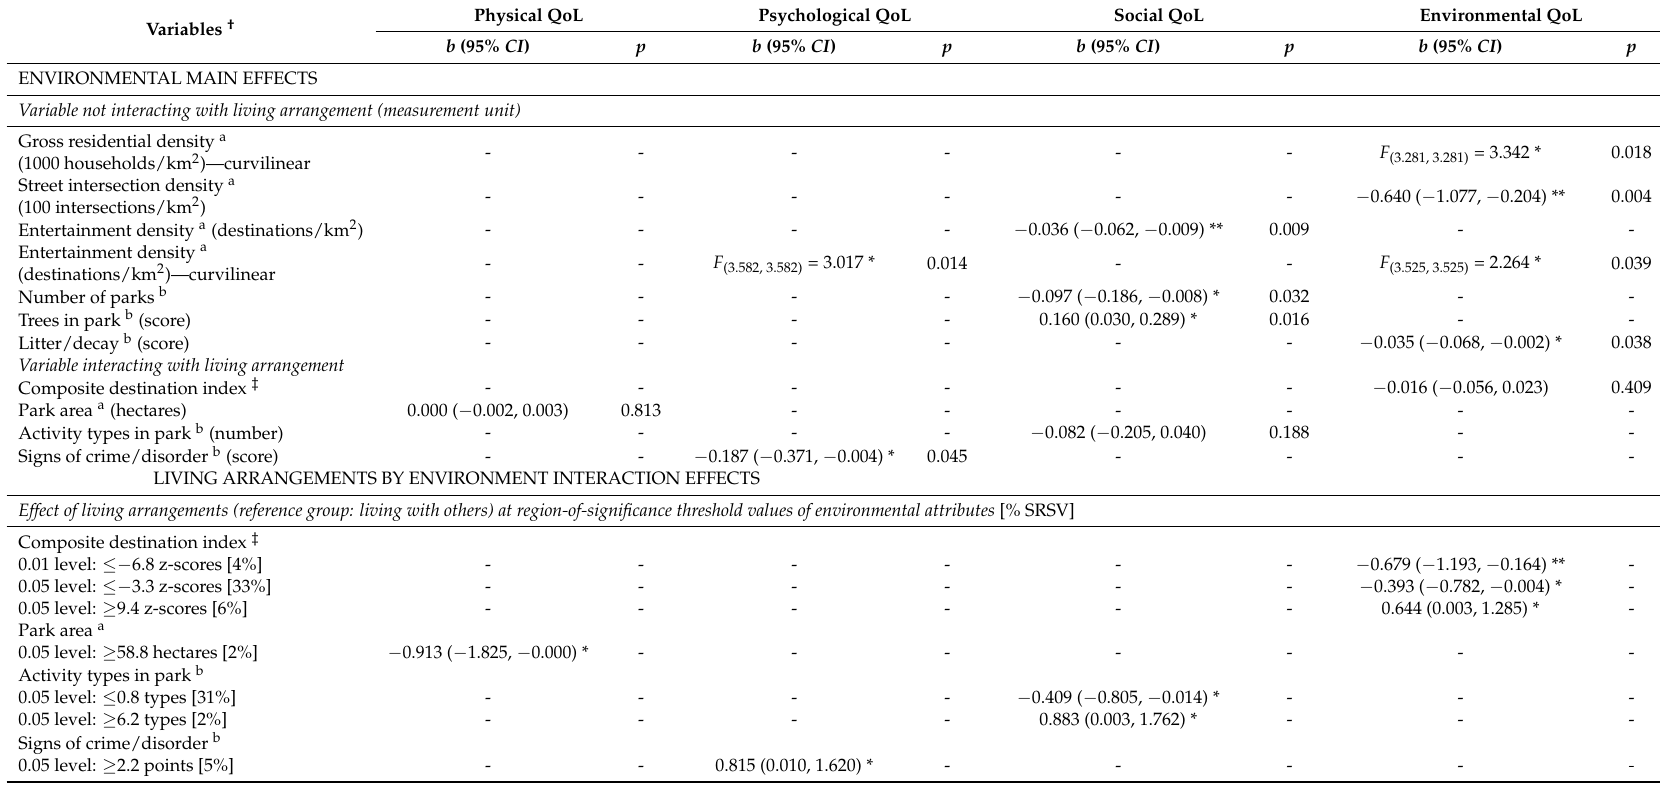
Table 4. Associations of multiple neighbourhood physical environmental attributes with quality of life (QoL)